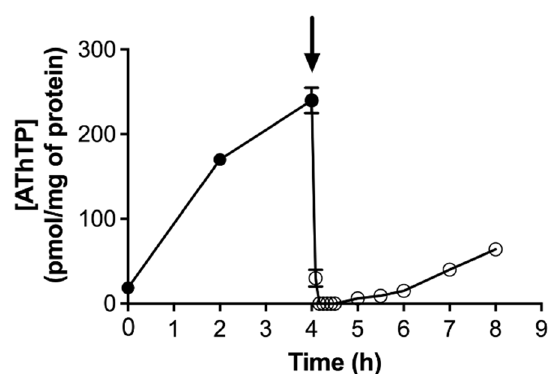
Figure 6. AThTP levels as a function of time in E. coli BL21 cells transferred to a minimal medium and incubated at 37 °C at 250 rpm in the absence of a carbon source. Aliquots were taken for determination of thiamine derivatives. The arrow indicates the addition of 10 mM D-glucose (mean ± SD, n = 3) (adapted from [103]).